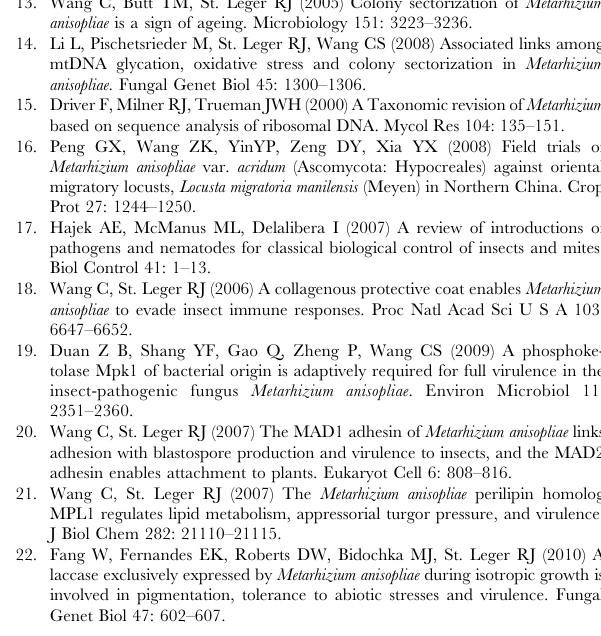
Table S15 The number of genes coding for protein kinases in Metarhizium anisopliae and M. acridum , arranged by class.